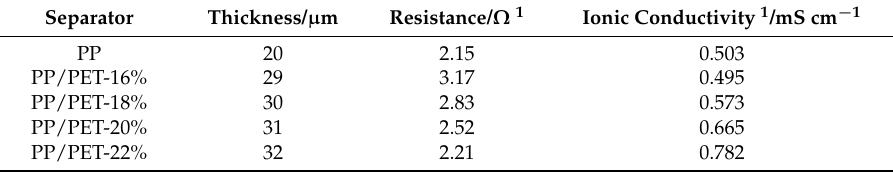
Table 1. The thickness, measured resistance, and ionic conductivity of the separators.